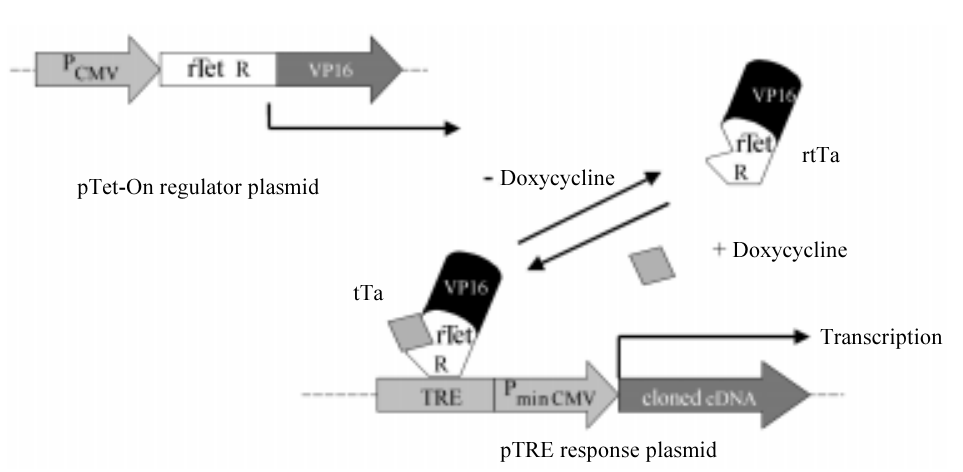
Figure 3 - Schematic presenta- tion of the Tet-On expression system. The reverse tetracy- cline-controlled transactivator (rtTa) is a fusion of a mutant TetR with the VP16 activator. In the absence of tetracycline, rtTa is free and transcription does not occur. When doxycycline is added to the cultures, it binds to rtTa which in turn binds tetracy- cline response elements (TRE), activating transcription of the cDNA. P minCMV = Minimum cy- tomegalovirus